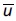
The predicted artificial flux as a function of stirring sensitivity and Reynolds stress.
A: The O2 concentration measured by a microelectrode increases non-linearly with the current velocity, here shown for a sensor with a stirring sensitivity of 0.7%. As a first approximation, the fluctuating velocities (u’) around their mean (u¯) can be transferred to the fluctuating concentrations (c’) around their mean (c¯) using the slope of the function at u¯ as a transfer factor (red lines in A). B: The first derivative of the transfer function, i.e. the transfer factor, decreases with velocity. C: The Reynolds stress in a logarithmic boundary layer increases as the square of the velocity, here assuming a roughness (z0) of 1 mm and a height above the seabed (z) of 15 cm. D: Applying equation 5, the Reynolds stress and the transfer factor can be combined to estimate the EC-flux from stirring sensitivity as a function of velocity. E: The artificial EC flux is plotted as a function of velocity according to equation 7 and as a function of Ssen (0.5–2%), c∞ (100–300µM) and z0 (0.1–10mm). The combination of parameter values is presented next to the functions.